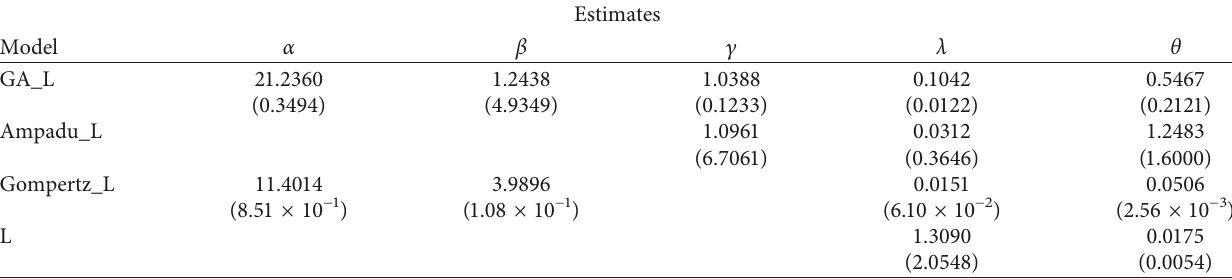
Table 3: The estimates and standard errors (in parentheses) for survival times.